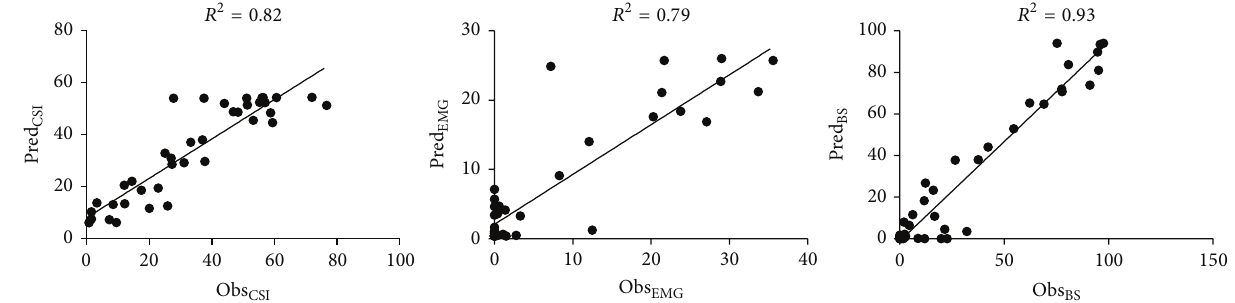
Figure 1: Representation of the observed effect (horizontal axis) versus the predicted effect (vertical axis) for the cerebral state index (CSI), the electromyographic activity (EMG), and the burst suppression ratio (BS). The coefficients of determination 𝑅 2 between the predicted and observed effects are also shown. Dots represent pooled data from all animals ( 𝑛 = 10 ) and the black line represents the regression line for the effects observed versus effects predicted by the inhibitory sigmoid 𝐸 max model.